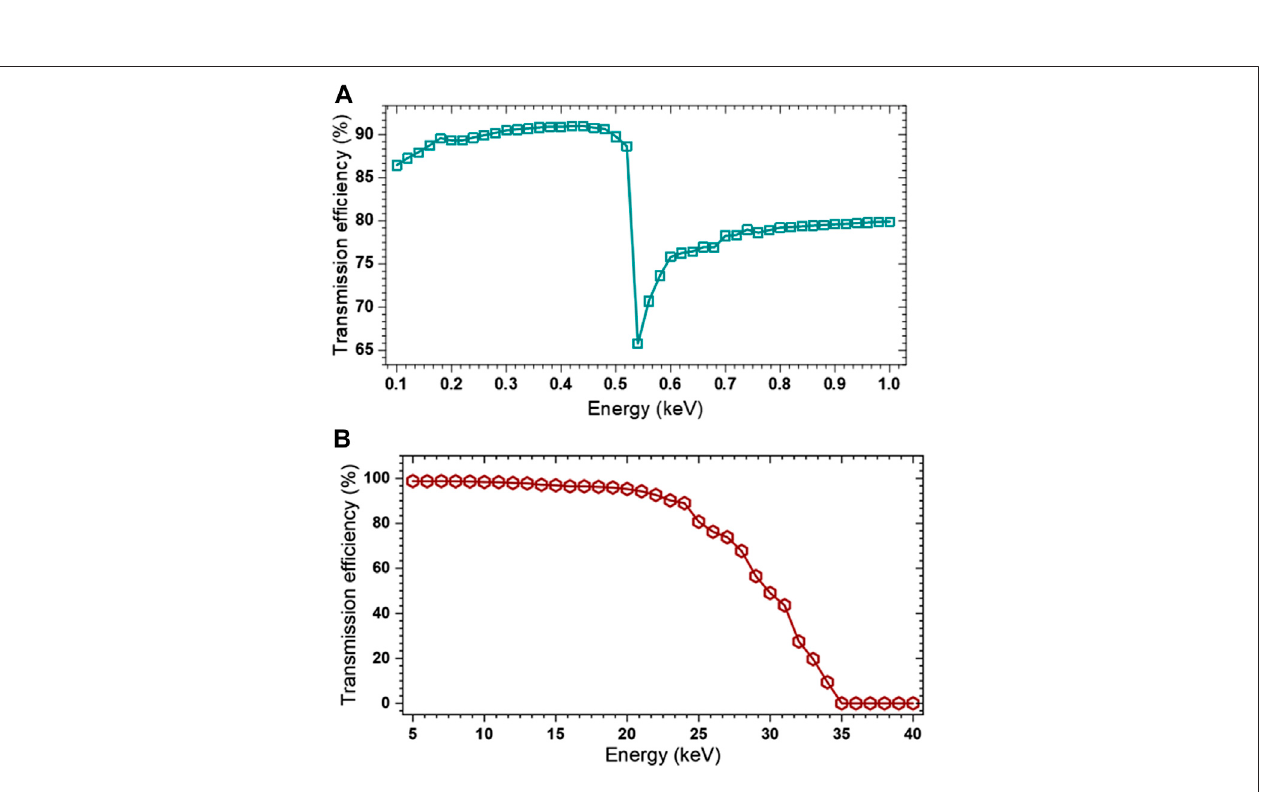
Frontiers in Physics |